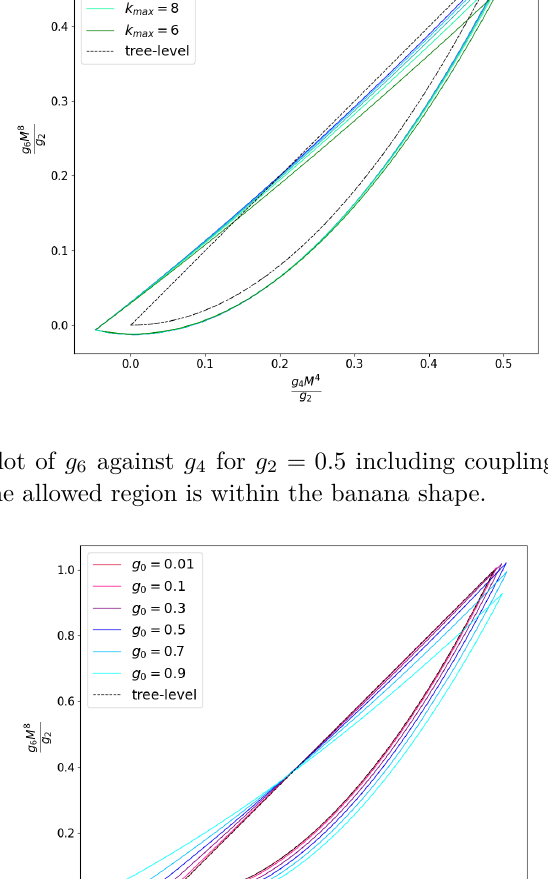
Figure 3 . Exclusion plot of g 6 against g 4 for various values of g 2 , tree-level bound for reference. To produce the bounds, we set g k = 0 for all k > 14